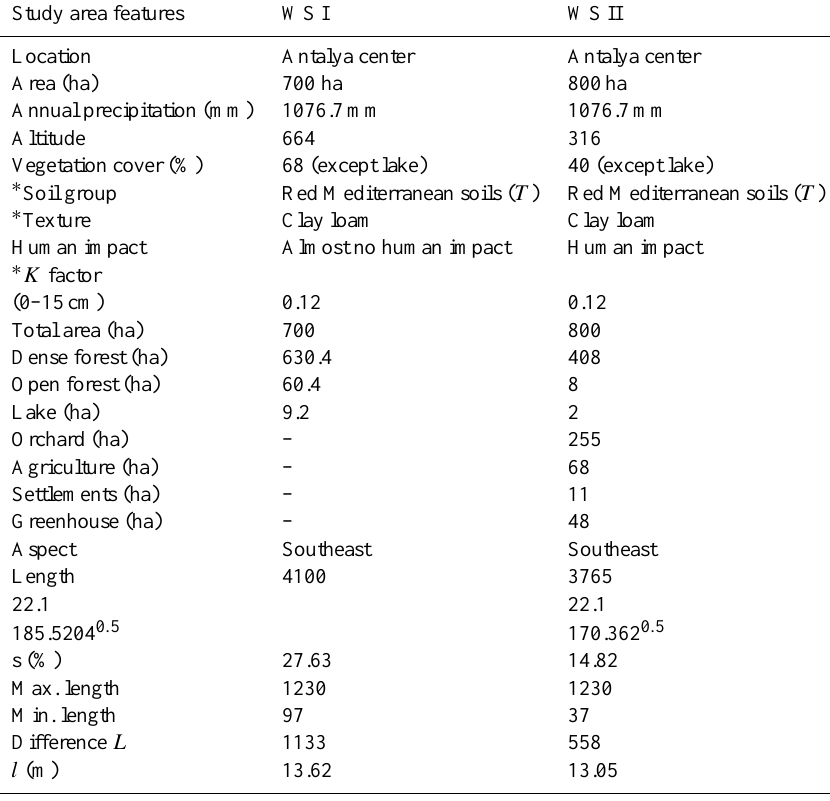
Table 1. Selected features of ∗ WS I and WS II obtained from GIS and previous studies; soil erodibility factor ( K ) in terms of soil group; some data from GIS and previous studies ∗ of WS I and WS II. Red Mediterranean soils ( T ); slope length factor ( l ); and slope steepness factor ( s